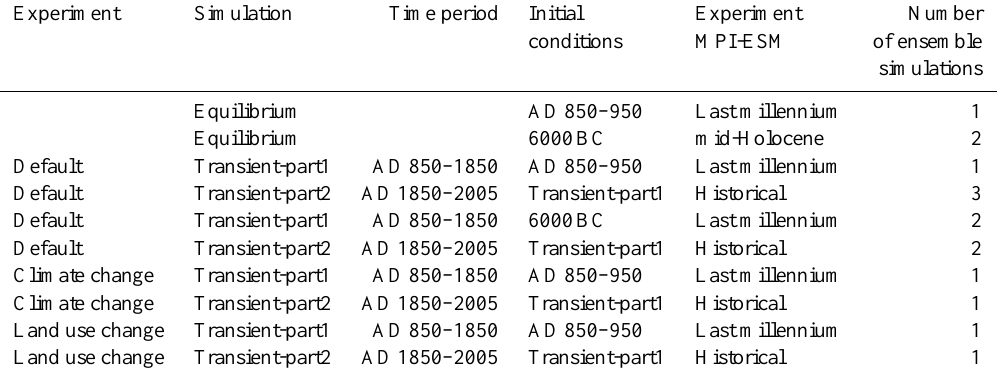
Table 1. Simulation specifications for the application of the sediment budget model on the Rhine catchment. For each experiment with the sediment budget model, the type of simulation (equilibrium or transient), the time period, and the initial conditions on which the simulation is based are given. Furthermore, we also provide the number of simulations we made with the model for a certain type of simulation, and the experiment from MPI-ESM that we used to derive the input data to force the sediment budget